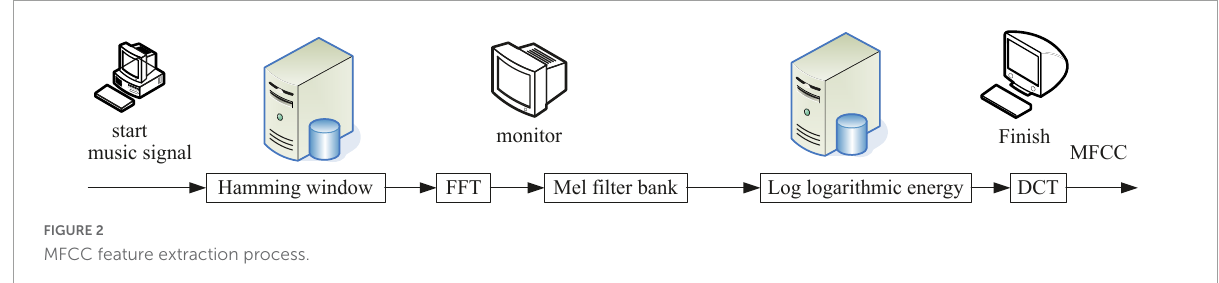
FIGURE2 MFCC feature extraction